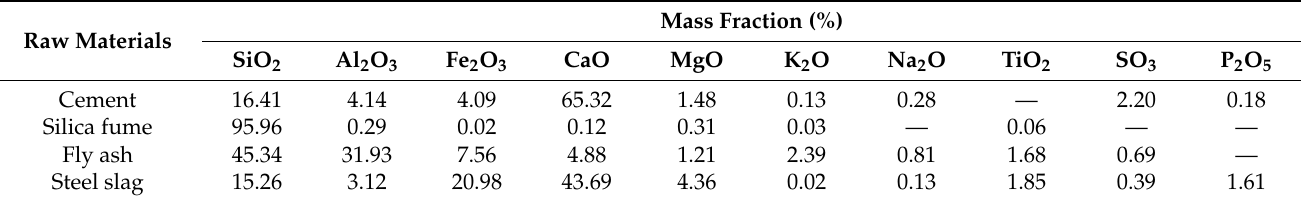
Table 1. Main chemical compositions of the raw materials